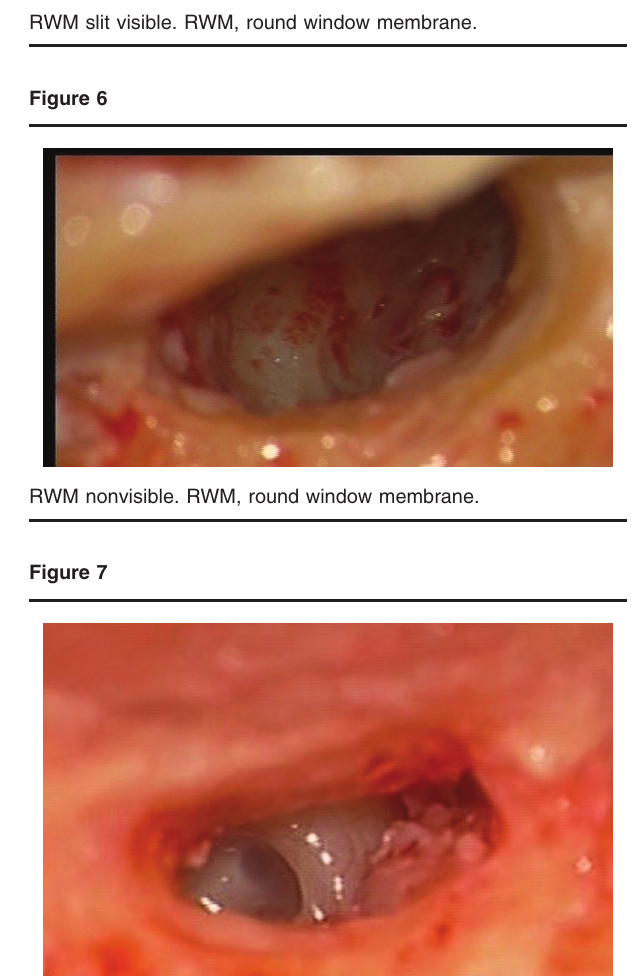
RWM slit visible. RWM, round window membrane.